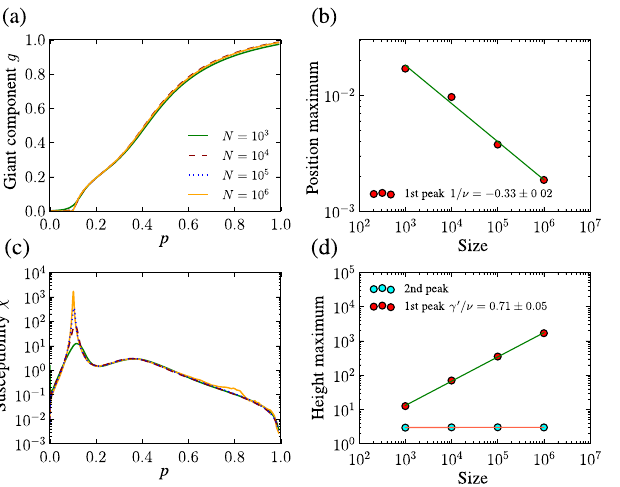
FIG. 9. Bond percolation simulations for the core-periphery random graph model for α ¼ 1 for different sizes. In both cases, the core has an average degree ¯ 2 . 5 . The core-periphery ratio is r ¼ 0 . 2 . (a) Relative size k p ¼ of the largest connected component as a function of the bond occupation probability p . (c) Susceptibility χ as a function of bond occupation probability p . (b, d) Position p χ of the two peaks of χ as a function of network size N . The max straight lines are power-law fits. Panels (b) and (d) show the measured values of the critical exponents.